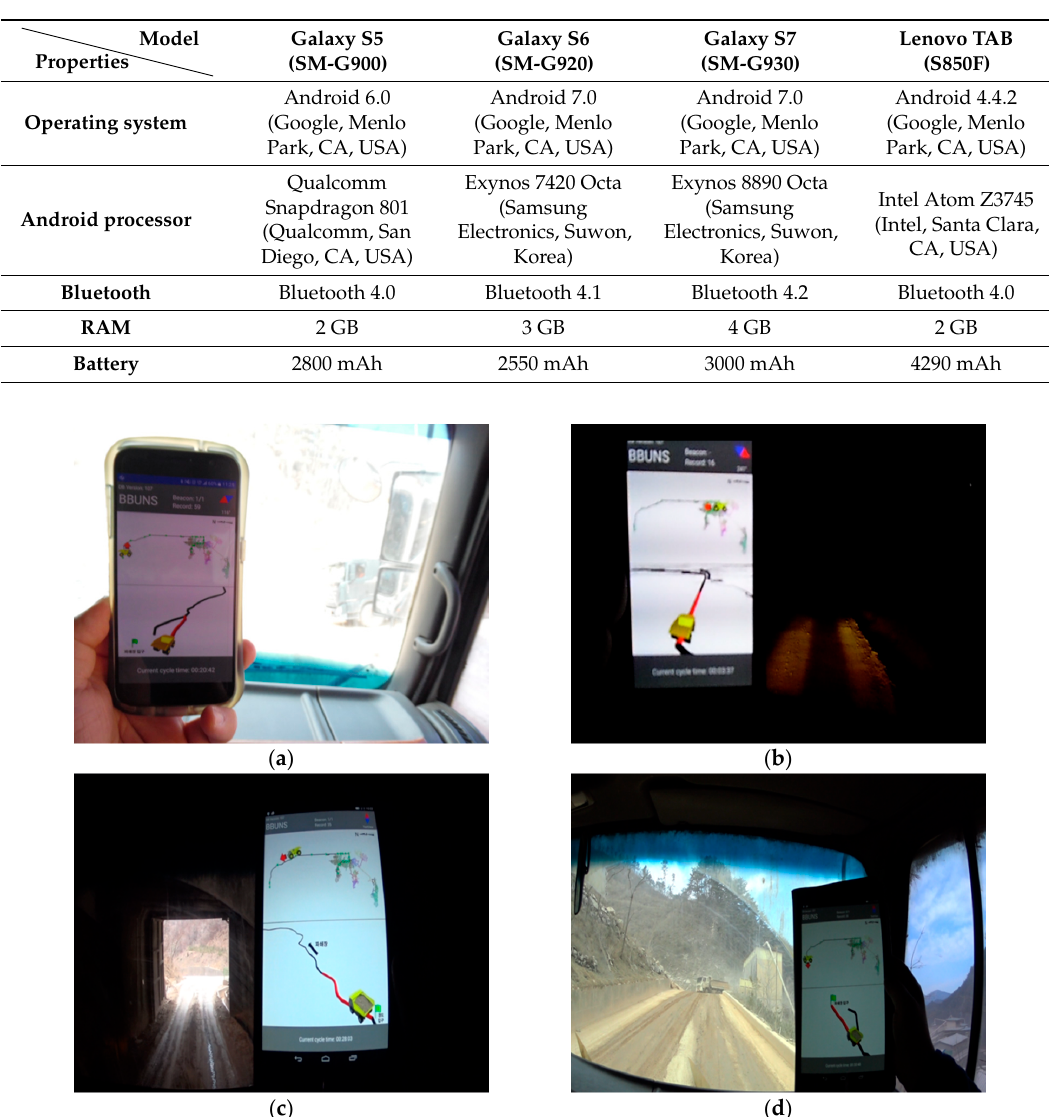
Figure 9. Results of testing the BBUNS application during the haulage operation when ( a ) leaving the crushing plant, ( b ) driving toward the 540 ML workplace, ( c ) passing by the portal of the underground mine, and ( d ) returning to the crushing plant.